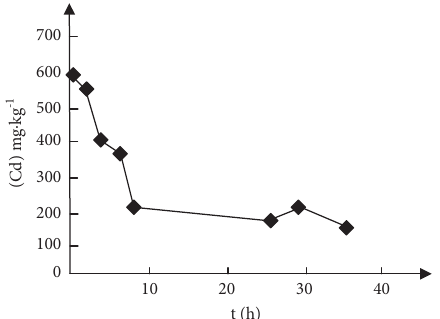
Figure 5: The change curve of cadmium in soil (+).